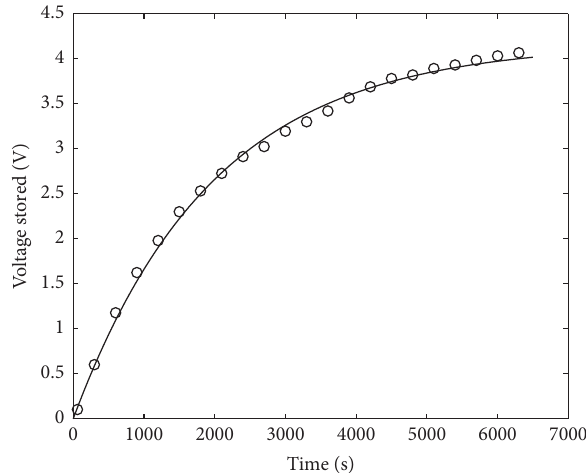
Figure9:ChargestoragecharacteristicsofthePZTenergyharvester measured at the optimum operating